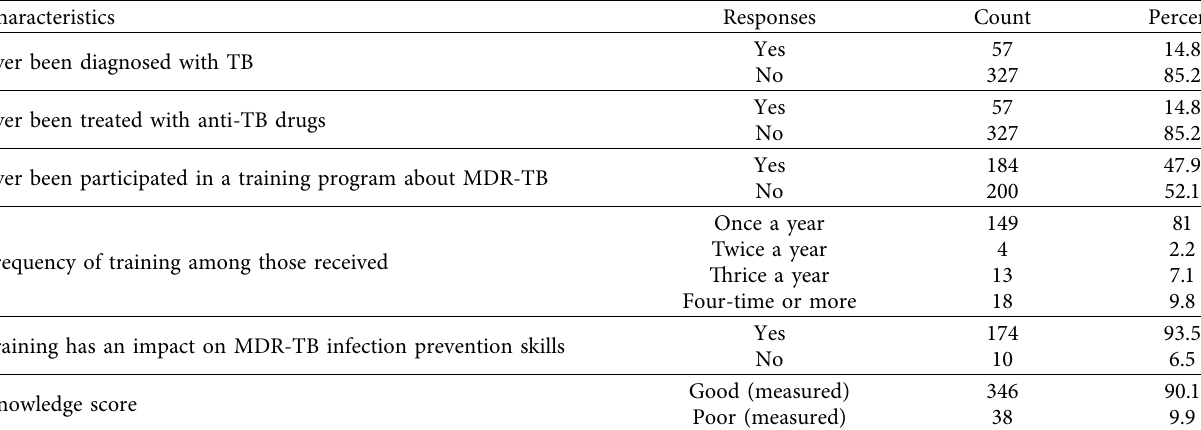
Table 2: Background general information responses of the HCWs to complement their attitude.